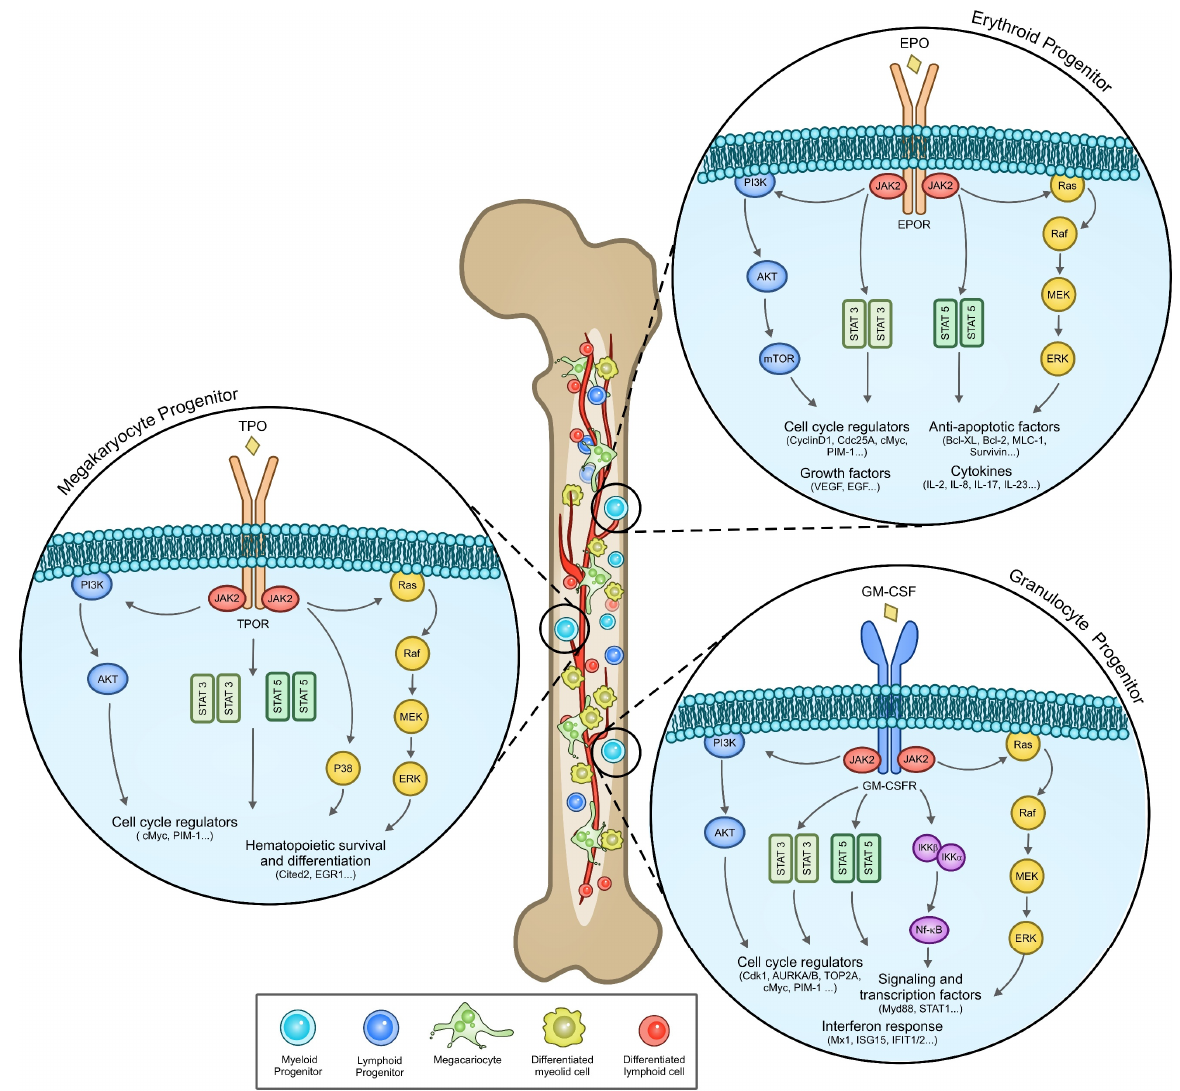
Figure 2. JAK2 signaling activated by three different surface receptors (EPR, TPO, and GM ‐